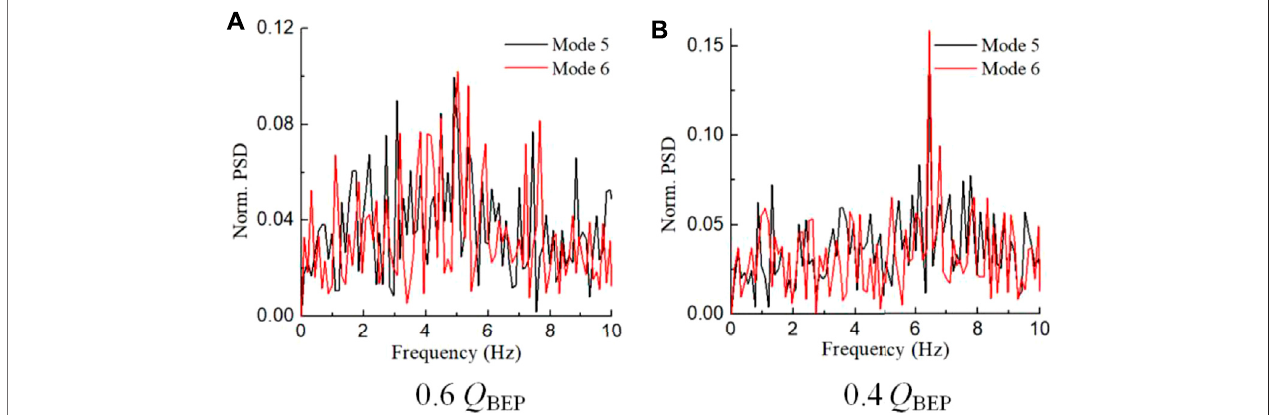
FIGURE 13 | FFT distribution of the fi fth mode and the sixth mode. (A) 0.6 Q BEP , (B) 0.4 Q BEP .